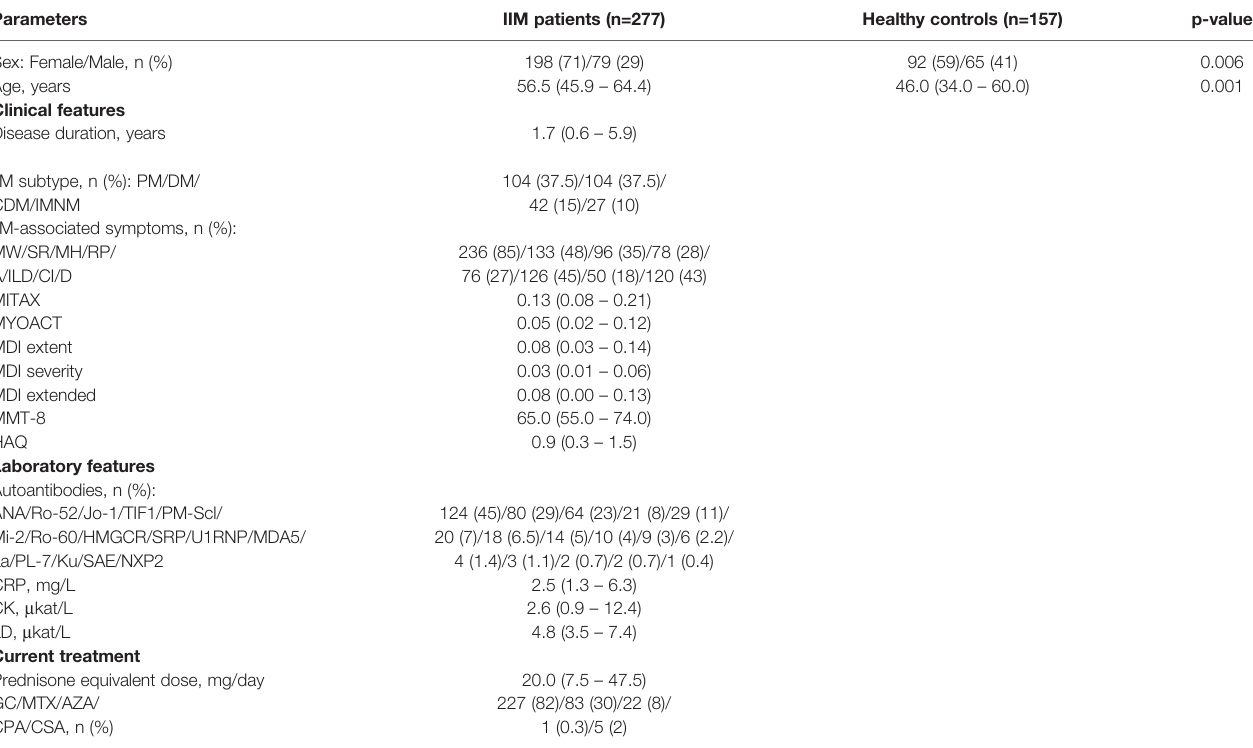
TABLE 1 | Clinical and demographic characteristics of IIM patients and healthy controls: cross-sectional cohort.